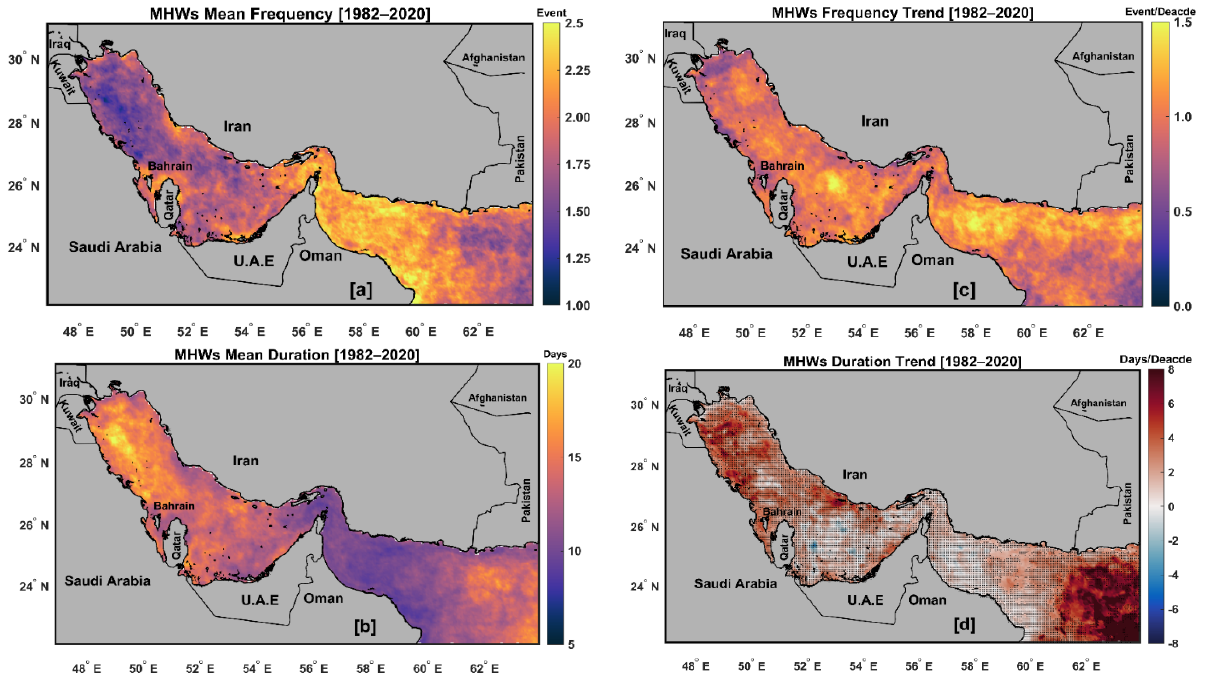
Figure 5. The spatial distribution of the annual MHW ( a ) mean frequency (events), ( b ) mean duration (days), ( c ) frequency trend (events/decade), and ( d ) duration trend (days/decade) from 1982 to 2020. Dotted regions show that the trend is statistically insignificant at the 95% confidence interval ( p > 0.05).